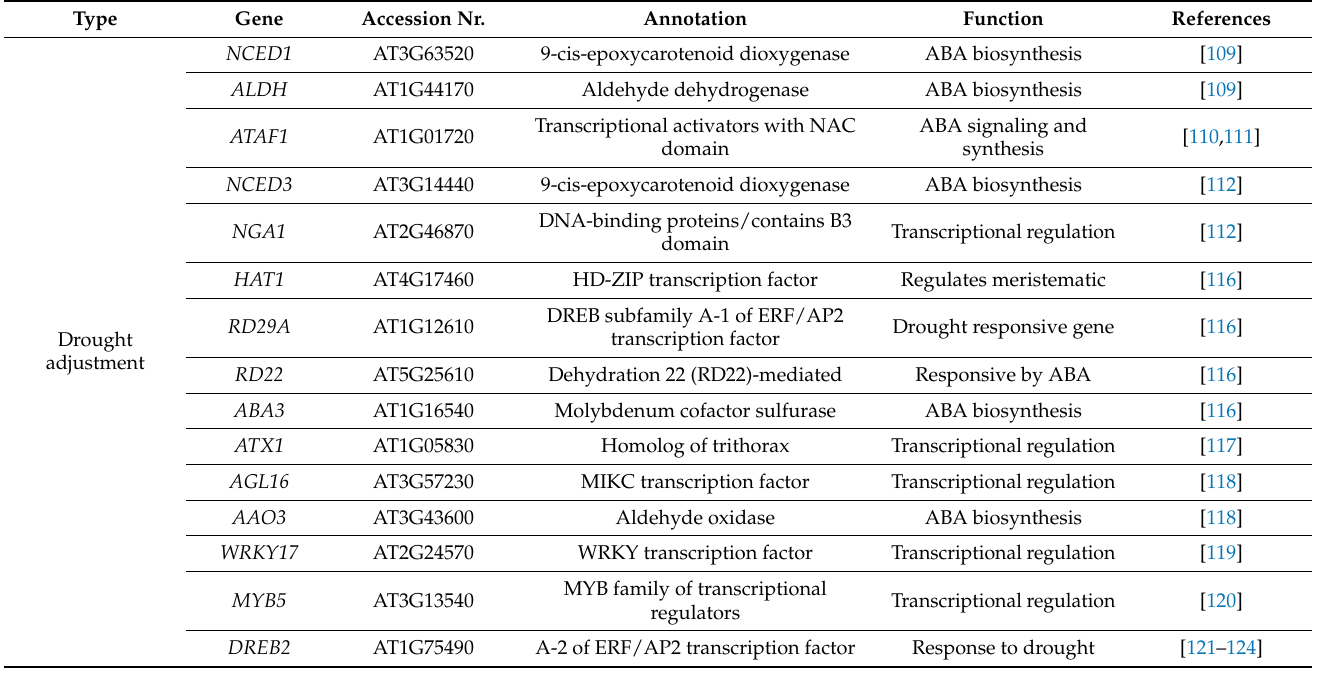
Figure 3. Regulatory mechanisms of phytohormones and related genes in response to waterlogging stress in plants. Table 2. Genes involved in drought and waterlogging adjustment.